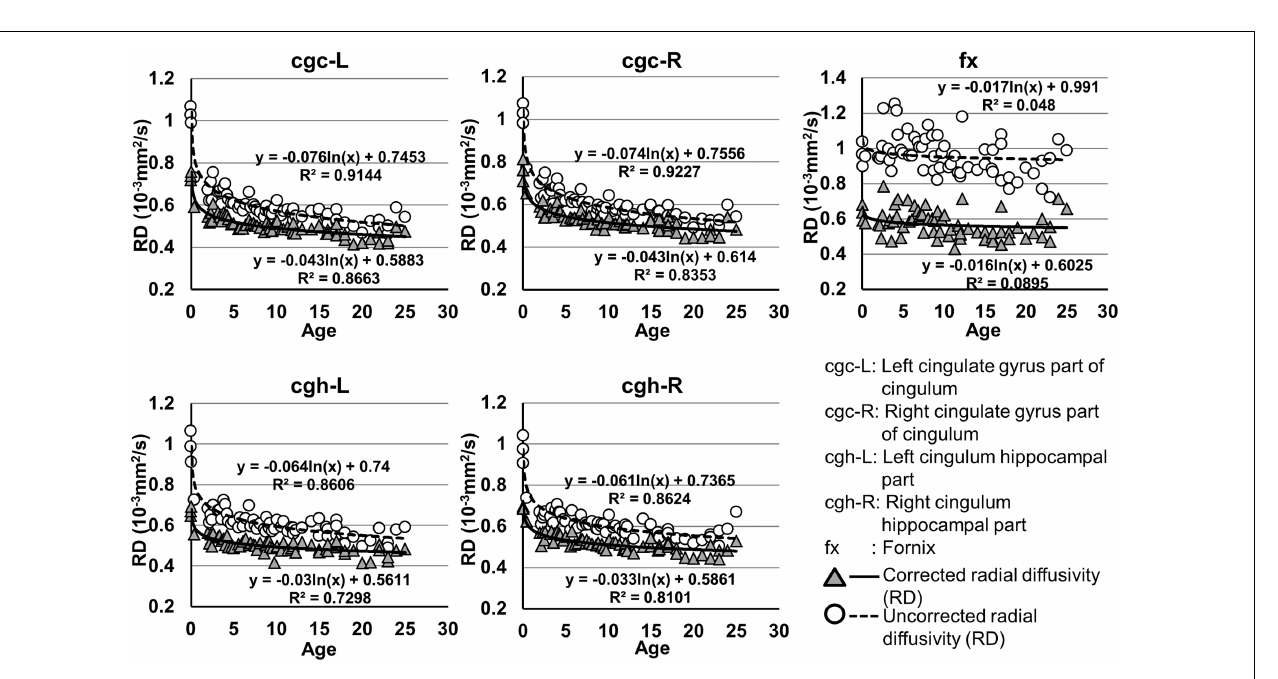
As shown in Table 5 , DTI metrics of all limbic tracts were significantly altered after FWE correction. FA increases due to FWE correction for fx is apparent in Figure 3 , while uncorrected